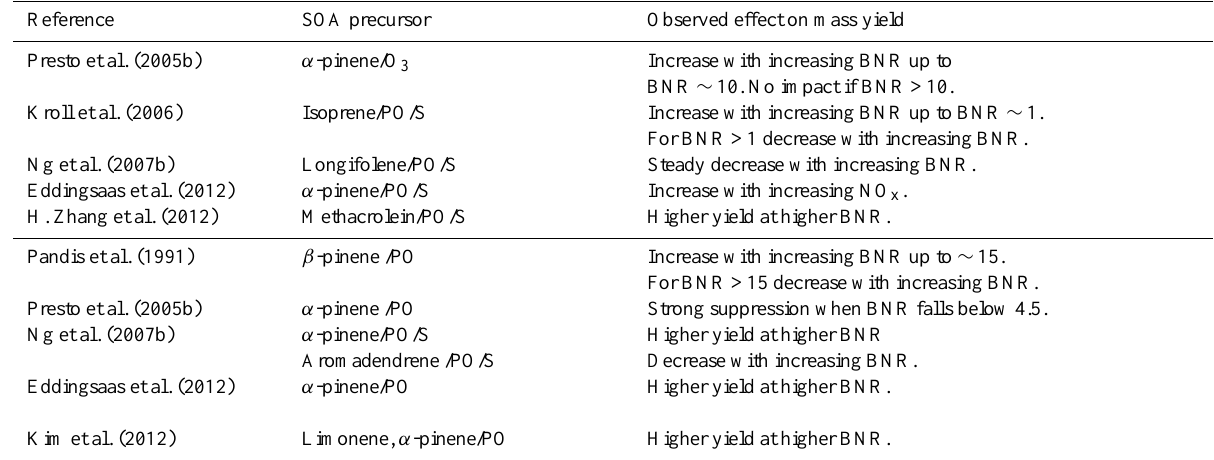
Table 2. Impacts of NO x on SOA formation from BVOC. PO, photooxidation; O 3 , ozonolysis; S, seed aerosol used. BNR is the